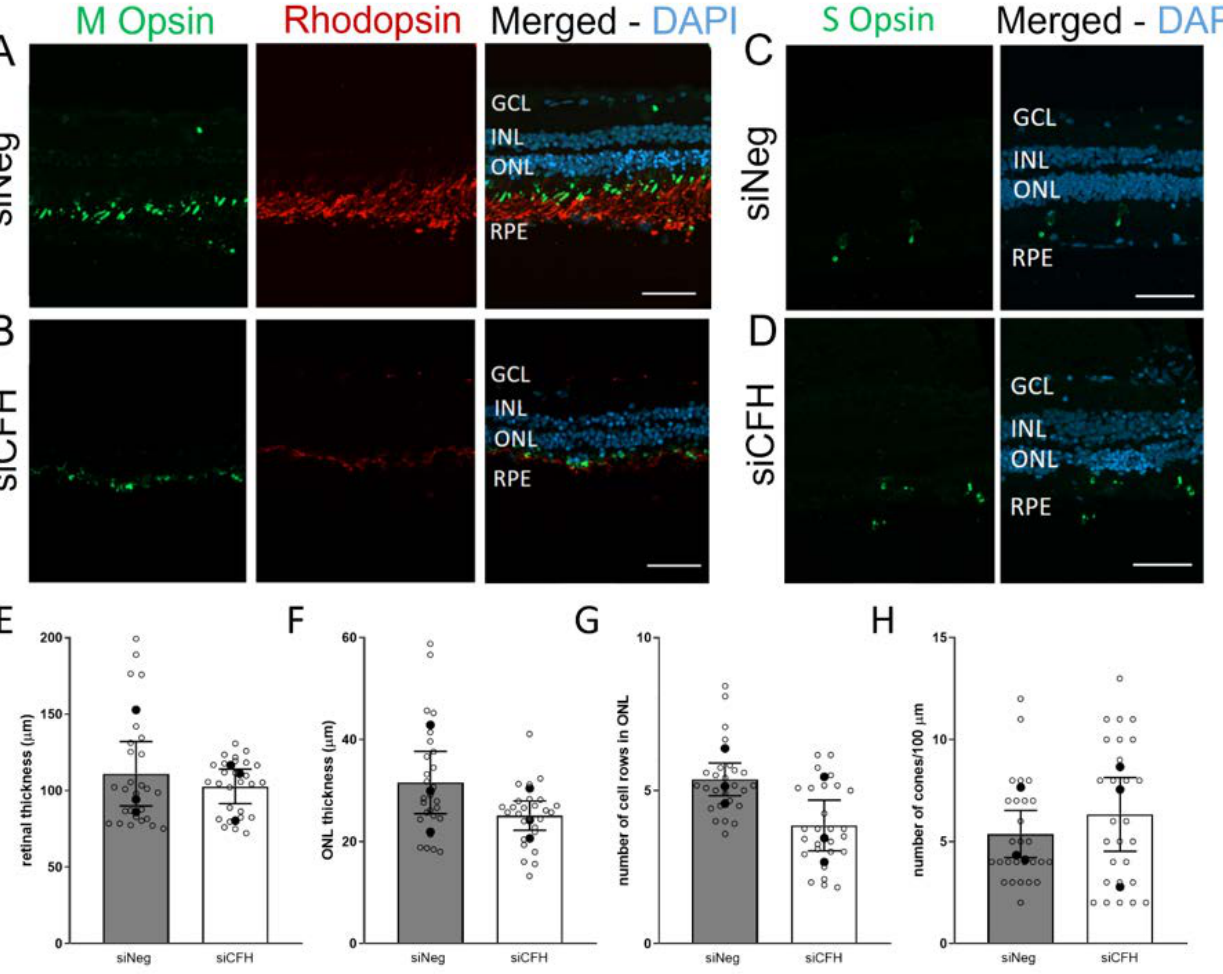
Figure 5. Changes mediated by FH loss in RPE cells in the co-cultured human retina. Human retinal explants from a single donor eye are exposed to either siNeg ( A – C ) or siCFH ( B – D ) hTERT-RPE1 cells for 72 h. ( A , B ) Explants cryosections were stained for M-Opsin (green) and Rhodopsin (red) to differentiate between cones and rods, and DAPI was used as counterstaining for nuclei. ( C , D ) Explants cryosections were stained for S-Opsin (green), and DAPI was used as counterstaining for nuclei to identify S-cones. ( E – H ) Quantification of retinal parameters extrapolated from ( A – D ): retinal thickness ( E ), ONL thickness ( F ), number of cell rows in ONL ( G ) and number of cones in ONL ( H ). Abbreviations: GCL—Ganglion cell layer, INL—inner nuclear layer, ONL—outer nuclear layer, RPE—retinal pigmented epithelium cells, siNeg—silencing negative control, si CFH —silencing CFH . Mean ± SEM is shown. N = 3 biological replicates from a single donor eye. Scale bar—50 µ